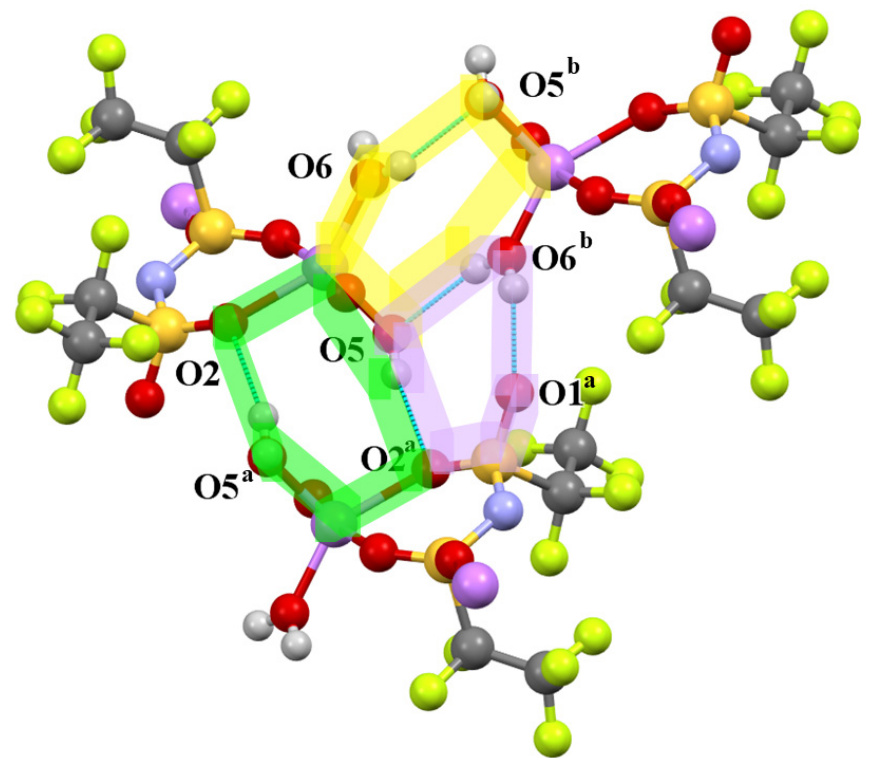
Figure 10. Depiction of hydrogen bonding ring interactions in [Li{BETI}(H 2 O) 2 ]. Different highlights are used to distinguish different hydrogen bonding rings which are formed. Green = 𝑅 (cid:2870)(cid:2870) (cid:4666)8(cid:4667);purple 𝑅 (cid:2871)(cid:2871) (cid:4666)8(cid:4667); yellow (cid:3404) 𝑅 (cid:2870)(cid:2870) (cid:4666)8(cid:4667). a = − x, 1 − y, 1 − z; b = − x, 2 − y, 1 − z.